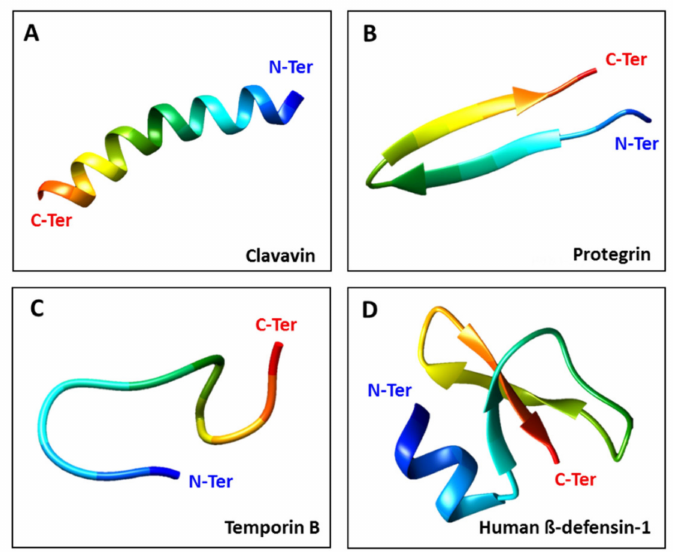
Figure 1. The four main structural classes of AMPs. ( A ) Clavavin adopts a typical α -helical confor- mation (10.2210/pdb6C41/pdb). ( B ) Protegrin PG-5 is a β -sheet peptide (10.2210/pdb2NC7/pdb). ( C ) Temporin B has a linear extension structure (10.2210/pdb6GIL/pdb). ( D ) Human β -defensin 1 features both α -helix and β -sheet structures (10.2210/pdb1IJV/pdb). The antiviral peptides were obtained from the Protein Data Bank (PDB) and adjustments were made using UCSF Chimera (http://www.cgl.ucsf.edu/chimera accessed on 22 April